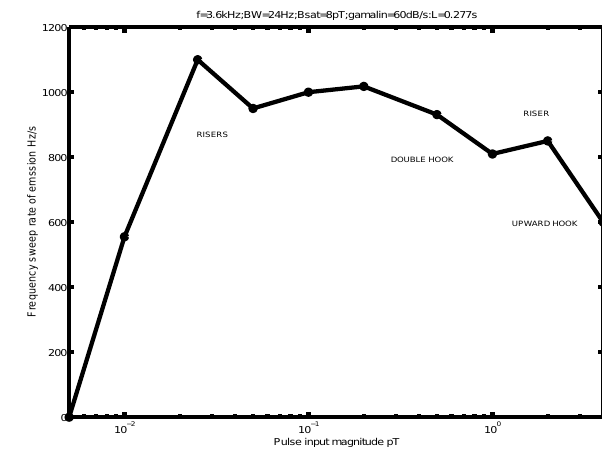
Fig. 9. Dependence of the emission sweep rate on the magnitude of the input pulse. The dependence is fairly weak; for very low amplitude input pulses triggering does not